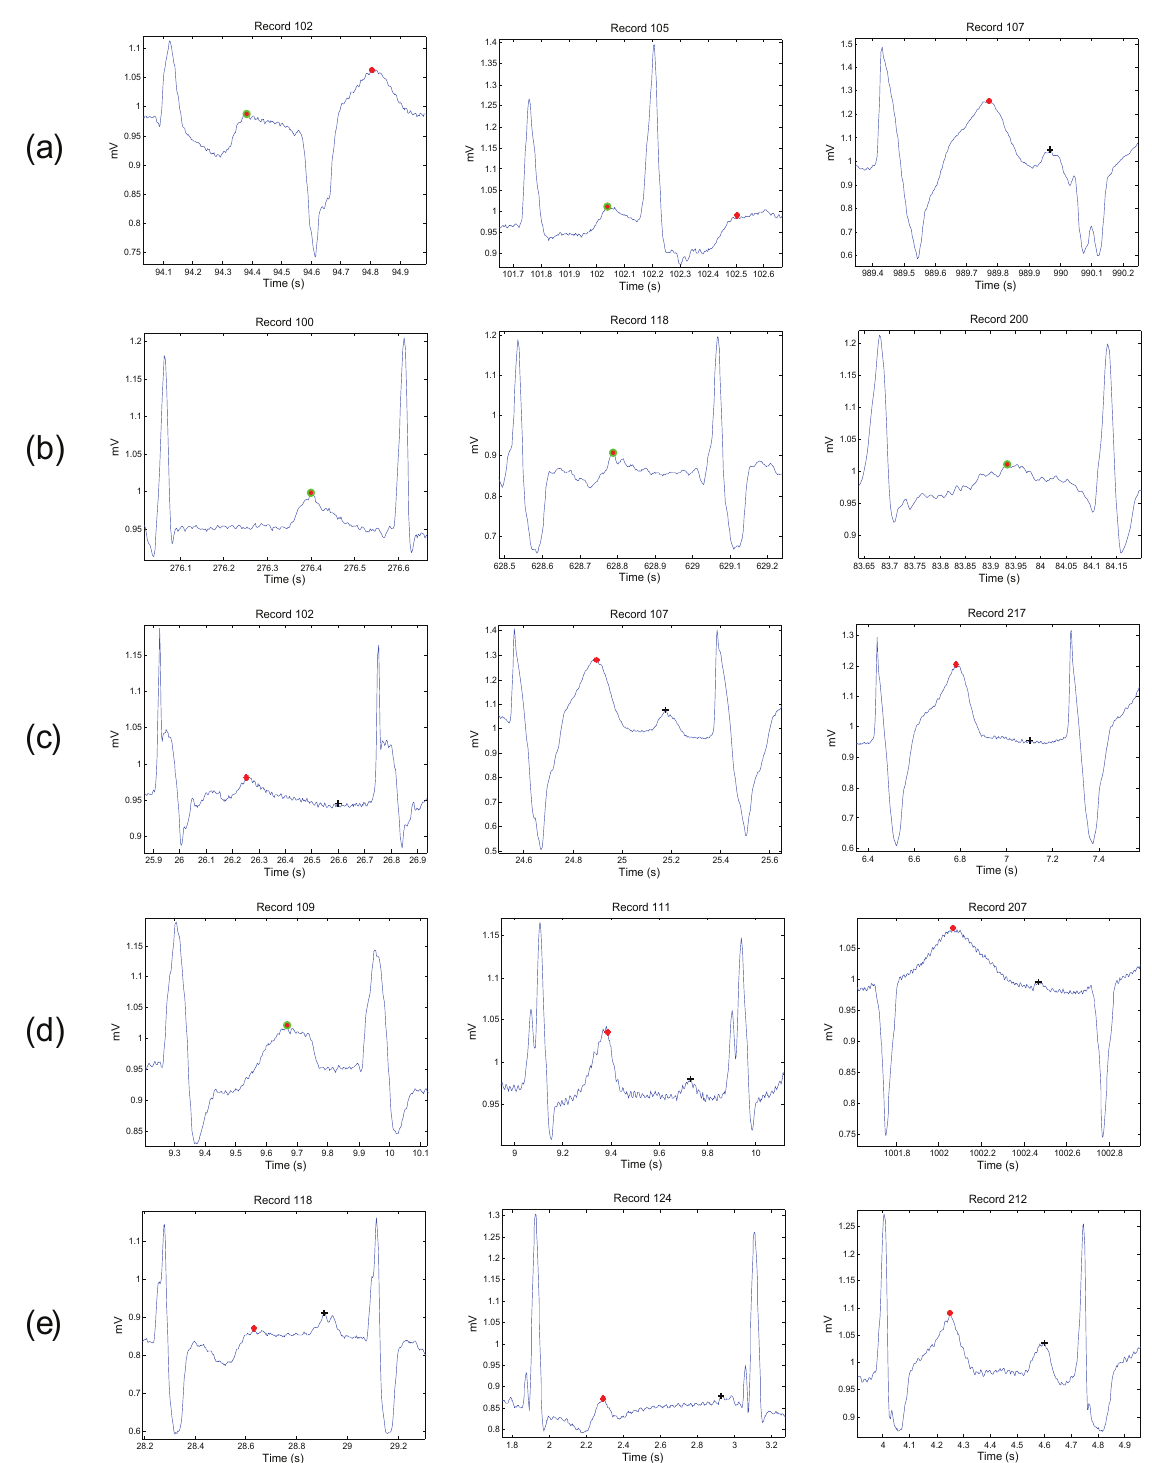
Figure 2. Annotation of Pand T waves in irregular heart beats. Each row contains three different morphologies for a certain type of arrhythmia: ( a ) premature ventricular beats; ( b ) premature atrial beats; ( c ) paced beats; ( d ) left bundle branch block beats; ( e ) right bundle branch block beats. Here, “+” represents the P wave and “*” represents the T wave, while the green circle with asterisk represents merged P and T